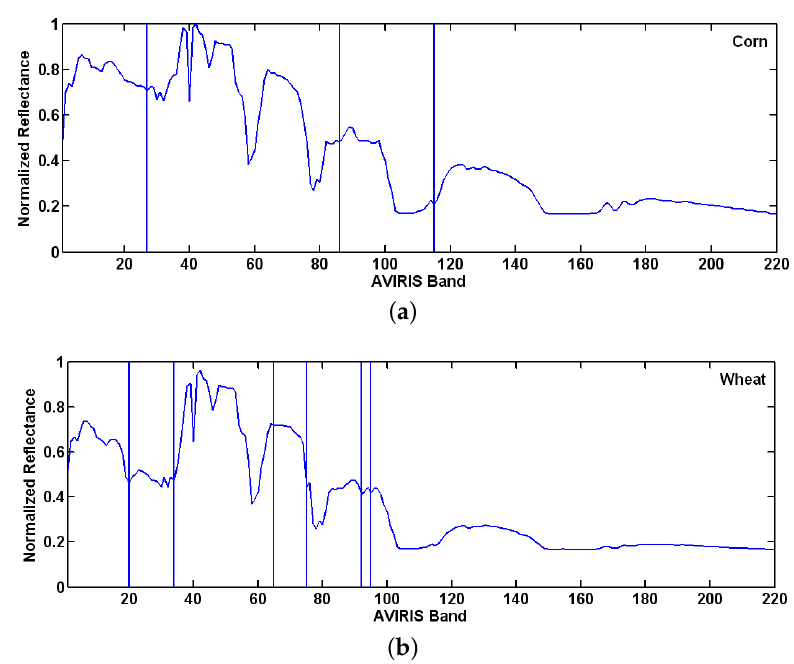
Figure 5. Spectral curves of two types of vegetation and their unique absorption features (labeled by vertical lines). ( a ) corn; ( b )